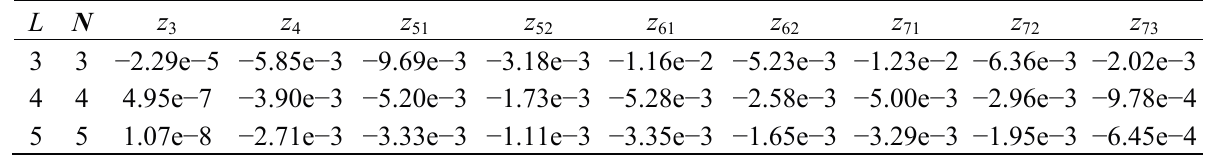
Table 14. Main attribution to maneuver error for LMShc algorithm.